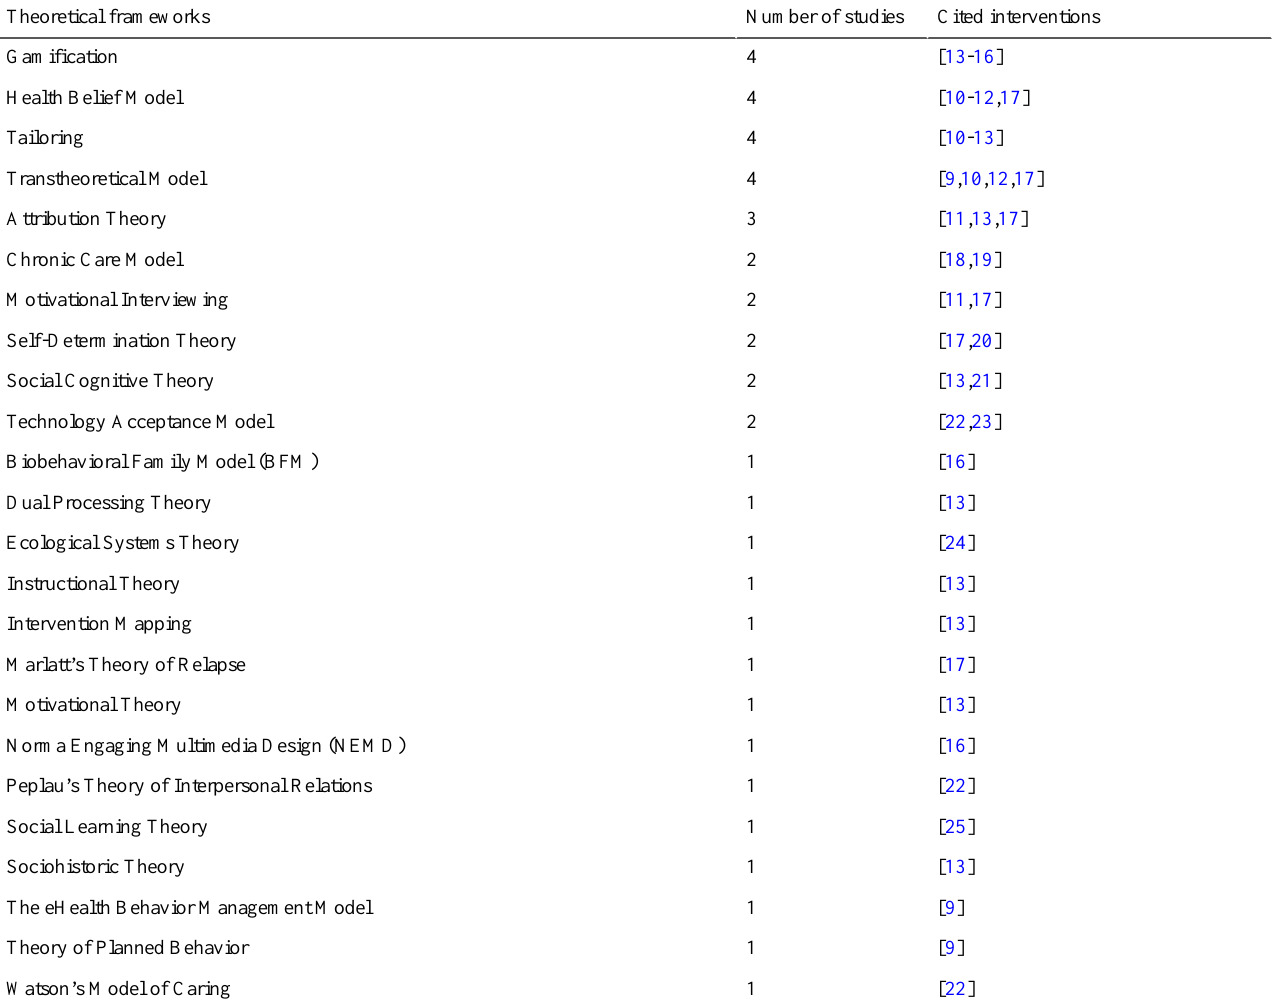
Table 1. Applied theoretical frameworks and models of the 85 reviewed Internet-based asthma